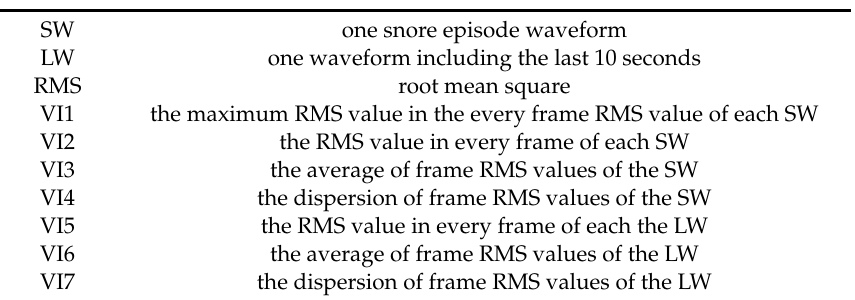
Figure 4. A long wave (LW) is defined as including the last 10 s before the end of the short wave (SW). Table 2. Details of volume information (VI). (SW, short wave; LW, long wave; RMS, root mean square; VI, volume information.).